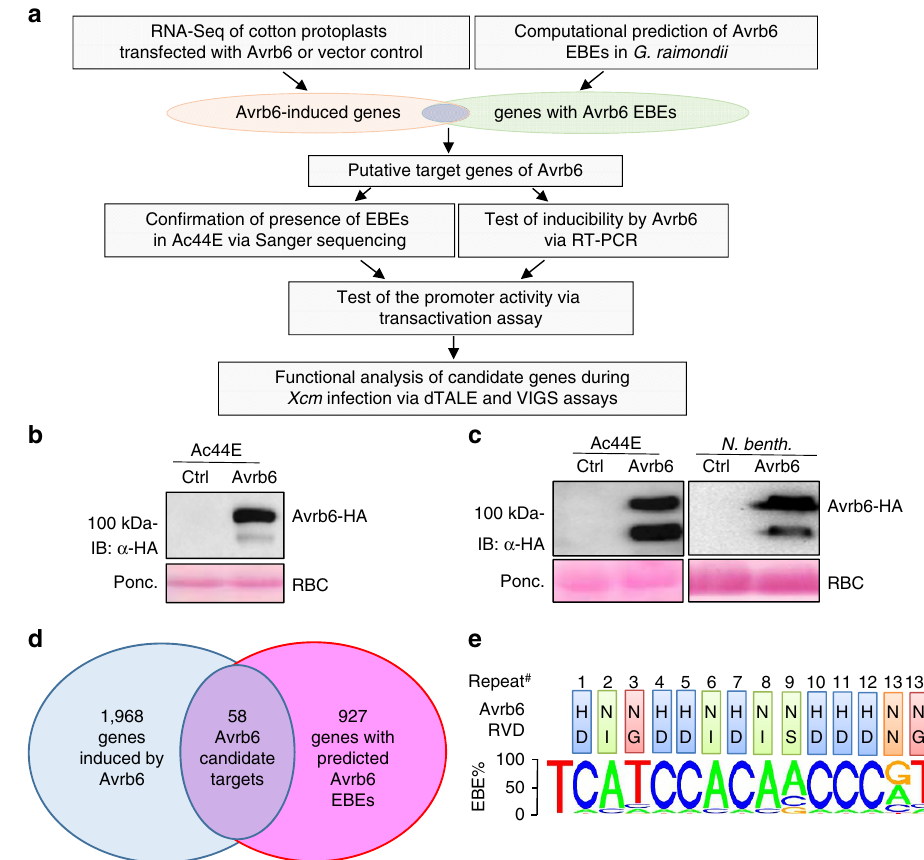
Figure 2 | Transcriptome profiling coupled with EBE prediction reveals candidate target genes of Avrb6. ( a ) Schematic diagram of experimental design to identify Avrb6 target genes in cotton. ( b ) Avrb6 protein expression in cotton protoplasts. Cotton protoplasts isolated from Ac44E were transfected with avrb6-HA or an empty vector as a control (Ctrl). Samples were collected 12h after transfection and subjected to immunoblotting with a -HA antibody (top panel). Ponceau S. staining (Ponc.) of total protein served as the protein loading control; RuBisCo (RBC) is shown (bottom panel). ( c ) Avrb6 protein expression in cotton and N. benthamiana . Cotyledons from 2-week-old Ac44E cotton and leaves of 4-week-old N. benthamiana were infiltrated with Agrobacterium carrying 35S::avrb6-HA or an empty vector control (Ctrl). Inoculated tissues were collected at 48 hpi and subjected to immunoblotting. B and C were repeated three times with similar results. ( d ) Venn diagram of Avrb6-induced genes and genes with Avrb6 EBEs in G. raimondii genome. ( e ) The predicted EBE of Avrb6 RVDs. Coloured boxes on the top panel display the RVD of each repeat of Avrb6. Bottom panel indicates the relative frequencies of RVD associations with the four nucleotides for each